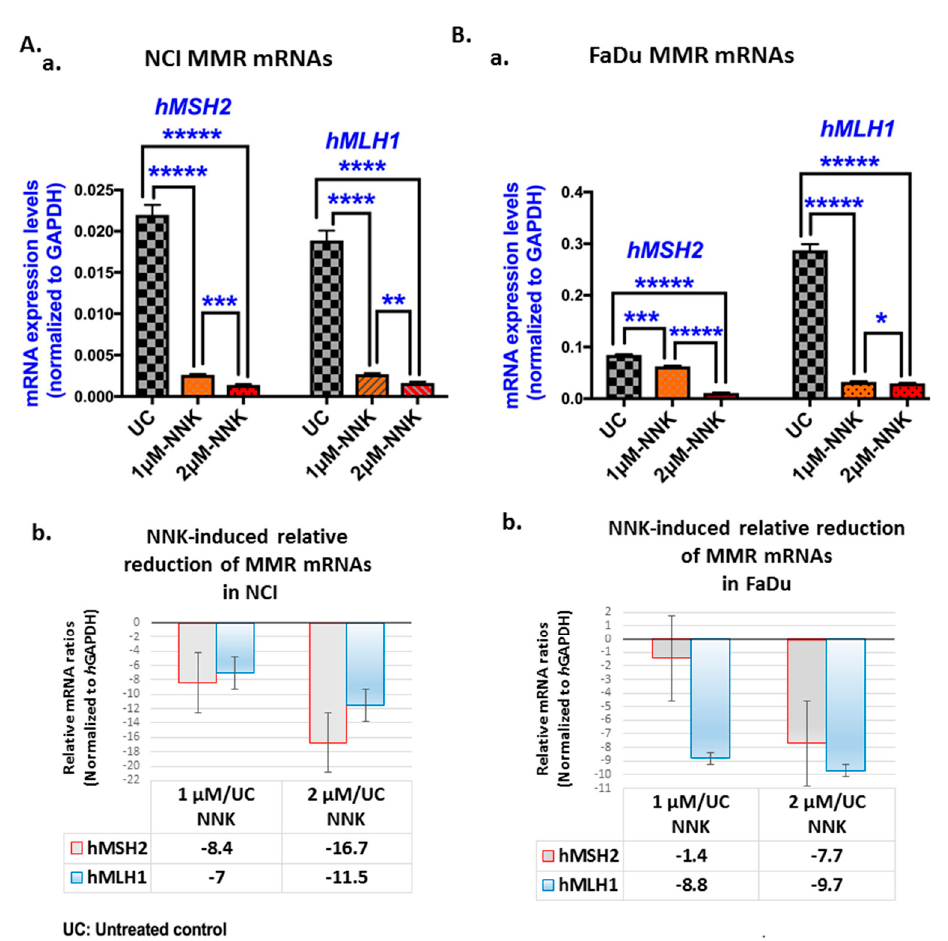
Figure 4. Either low or high dose of NNK reduces hMSH2 and hMLH1 mRNAs in both ( A ) NCI and ( B ) FaDu. ( A - a and B - a ) Graphs depict the transcriptional levels of the MMR genes, hMSH2 and hMLH1 (relative to h GAPDH reference gene) induced in untreated and NNK-treated NCI and FaDu. Data were obtained from real-time qPCR analysis. (Graphs, created by GraphPad Prism 7 software; *** p < 0.0005; **** p < 0.0005, ***** p < 0.00005; by t -test; multiple comparisons by Holm-Sidak). ( A - b and B - b ) The graphs illustrate the NNK-induced mRNA reduction, as demonstrated by the relative mRNA ratios of MMR genes ( hMSH2 and hMLH1 ) in NNK-treated (at 1 µ M and 2 µ M) NCI and FaDu, respectively, versus untreated controls. (Data were obtained from three independent experiments).